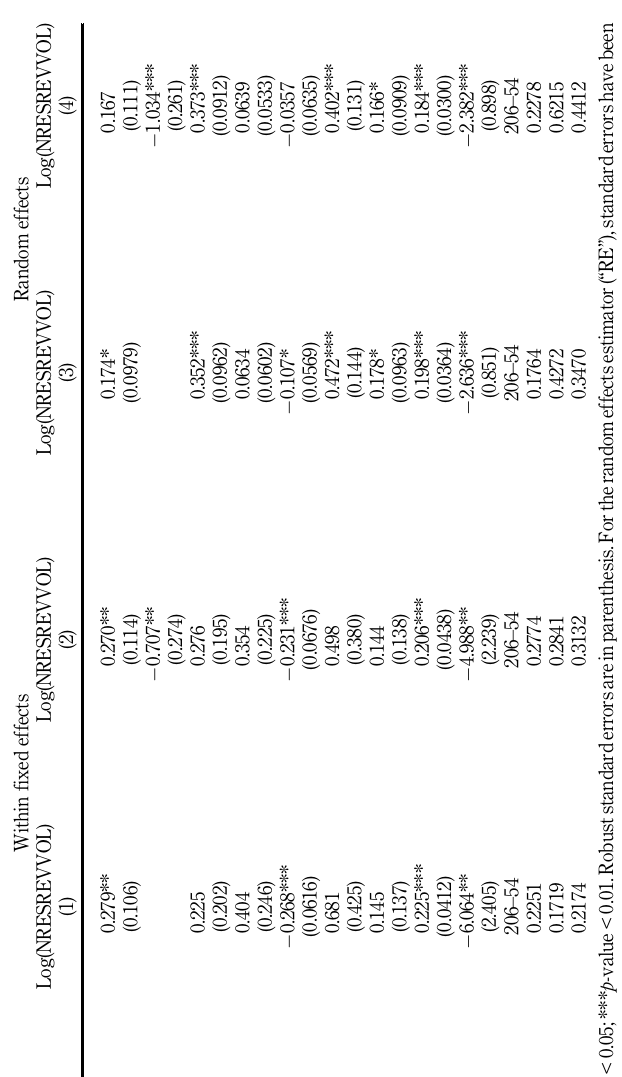
Table 1. Impact of the volatility of resource revenue on the volatility of non- resource revenue. Estimator : Within fixed effects and random